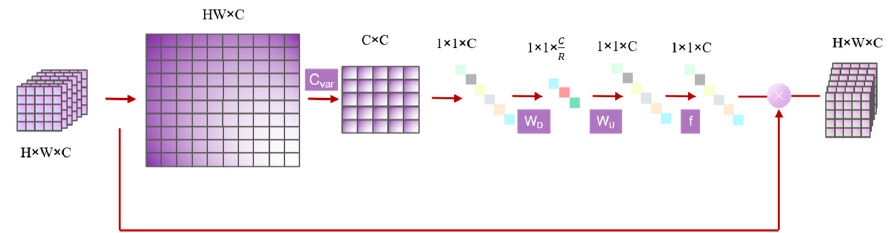
Figure 6. The process of second-order channel attention. H × W × C represents the feature map with length H, width W, and number of channels C. C var , W D , W U , and f represent the covariance calcu- lation, the fully connected layer for down-sampling, the fully connected layer for up-sampling and the sigmoid activation function,